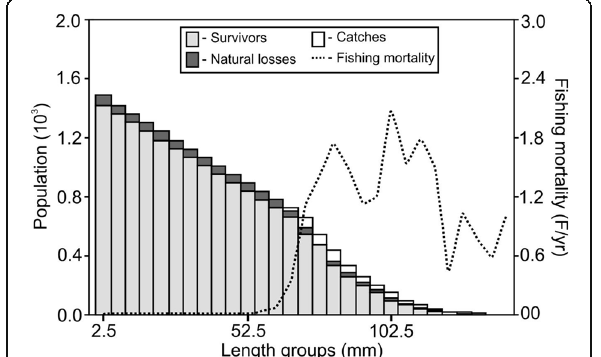
Fig. 4 Length-based virtual population dynamics for